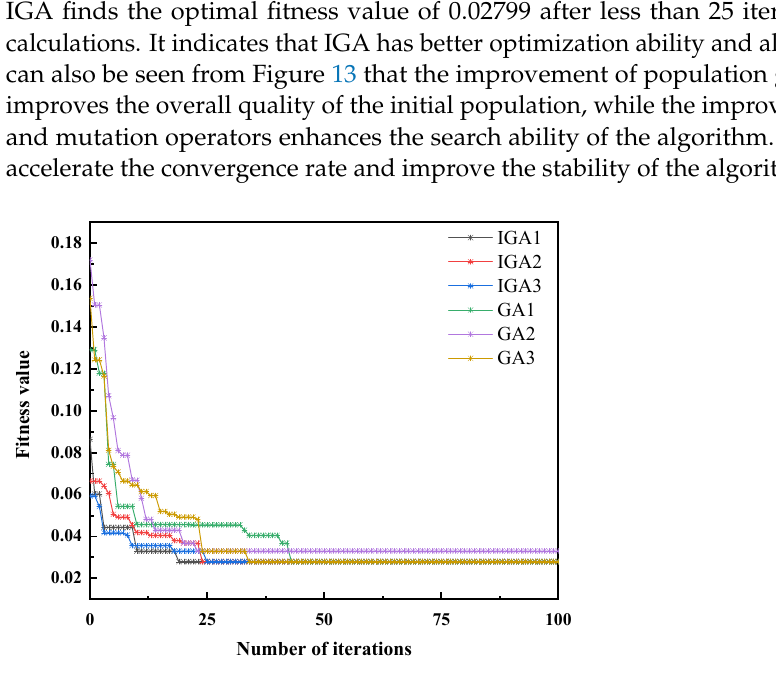
Figure 12. Removed loads distribution in Scenario 2.